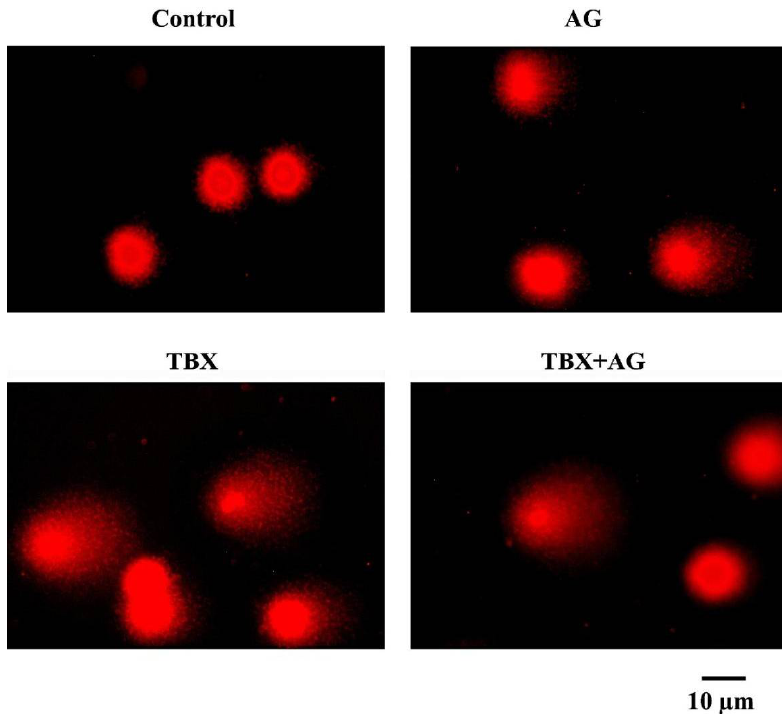
Figure 7. Representative photomicrographs of comet assay (ethidium bromide-stained) showing the protective effect of AG against TBX-induced DNA strand breaks in isolated peripheral blood leucocytes of treated rats after 24 h of treatments (Olympus CX23 microscope, Tokyo Japan). AG: 10% Arabic gum, TBX: Telebrix (1600 mg I/kg b.wt.) and TBX+AG: co-treatment with 1600 mg/kg b.wt. and 10% Arabic gum.